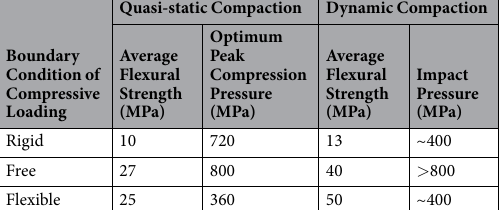
Boundary Condition of Compressive